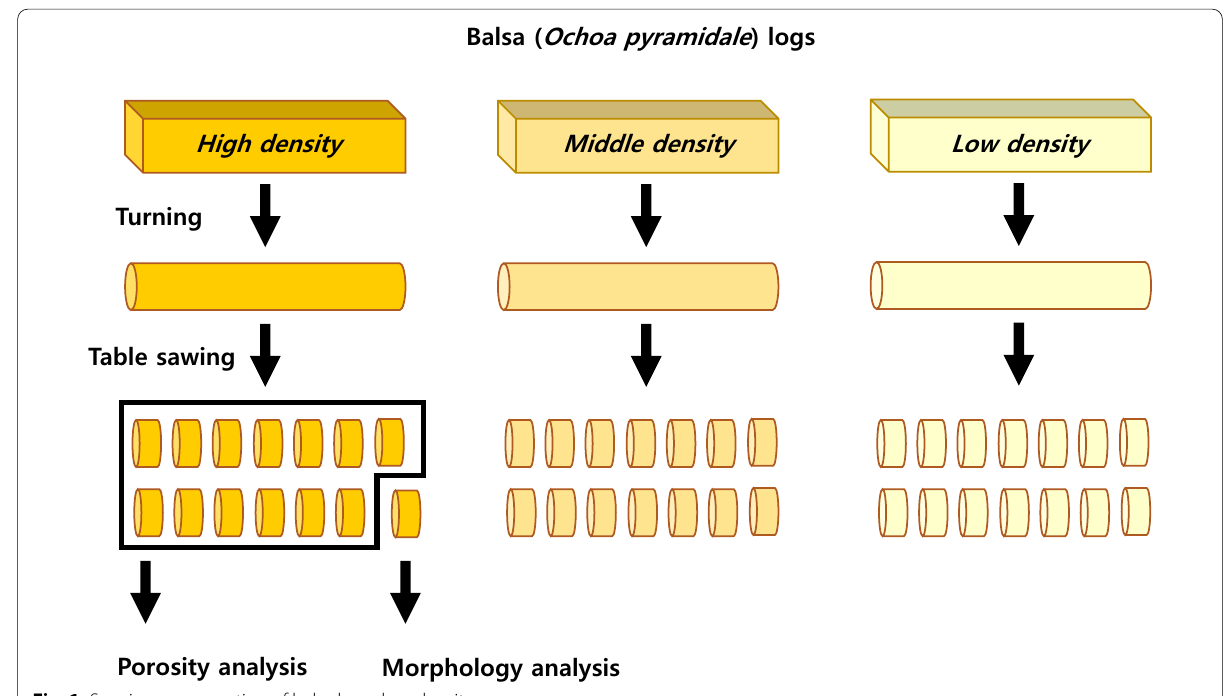
Fig. 1 Specimen preparation of balsa based on